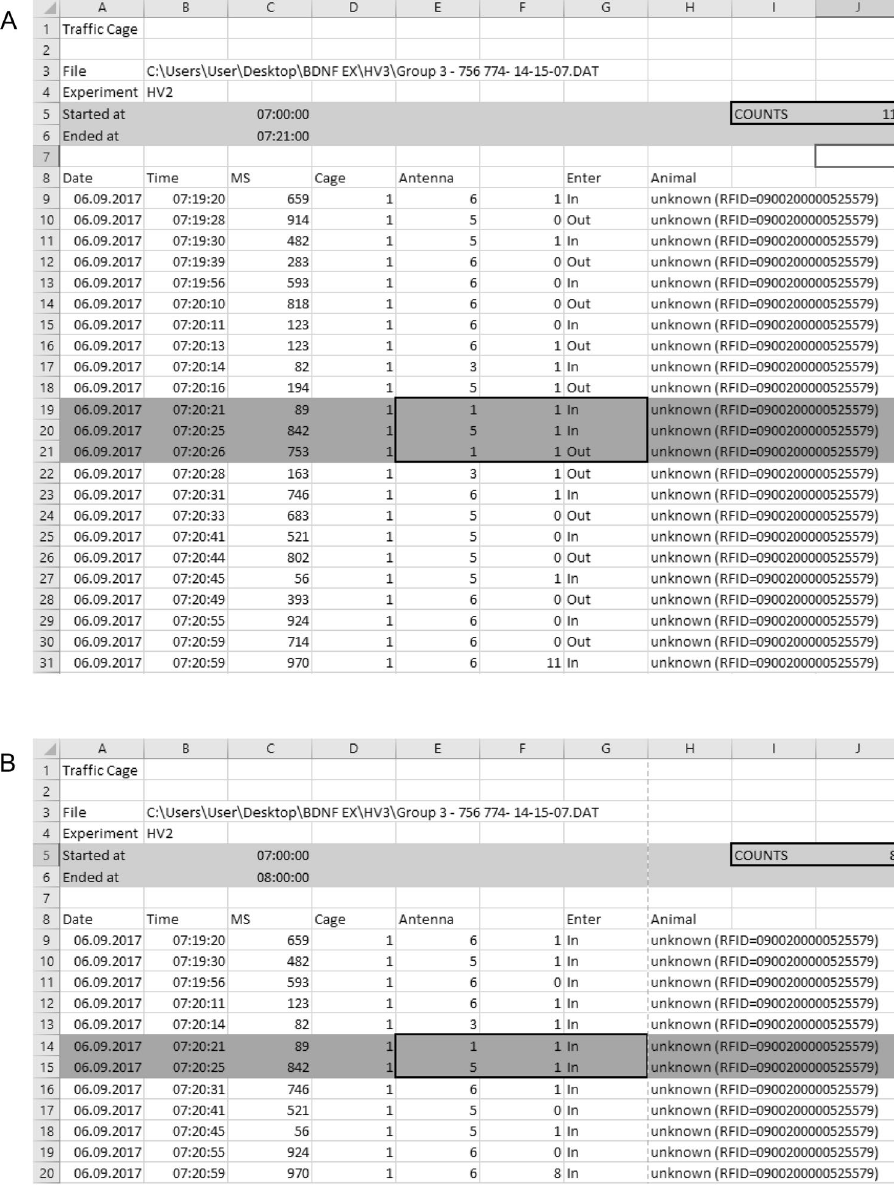
registering antenna has changed or not between two measurement points, Excel notes a one or a zero in the next column. ( A ) By summing up all entries, the user receives the number of field changes over a chosen time period. ( B ) Using this method, Excel frequently counts more field changes than the animal actually